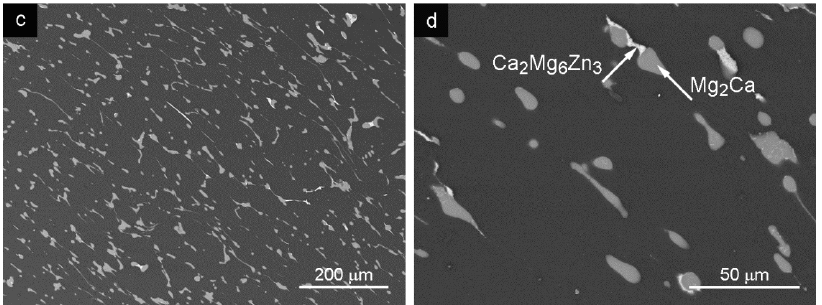
Figure 4. Microstructure of the ECAPed alloy: ( a ) ECAPed state; ( b ) secondary phases in the ECAPed state; ( c ) HT + ECAP; ( d ) secondary phases in HT + ECAP state depicted in the SEM–BSE mode.